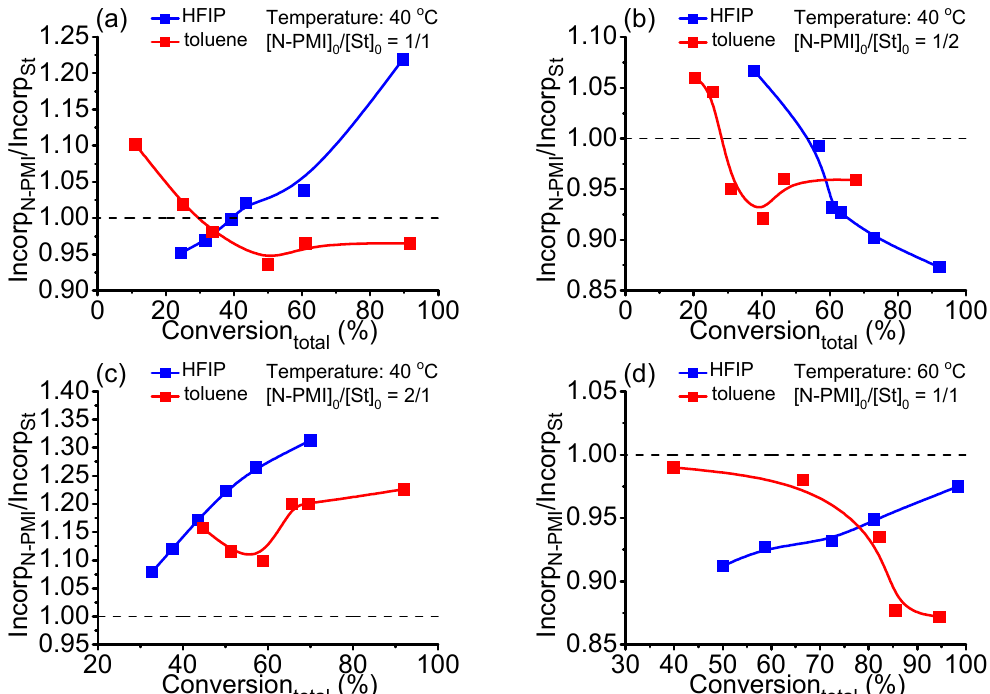
Figure 2. Incorp N-PMI /Incorp St of resultant copolymer in HFIP and toluene. ( a ) [N-PMI] 0 /[St] 0 /[CPDN] 0 /[AIBN] 0 = 250/250/2/1, 40 °C; ( b ) [N-PMI] 0 /[St] 0 /[CPDN] 0 /[AIBN] 0 = 167/333/2/1, 40 °C;